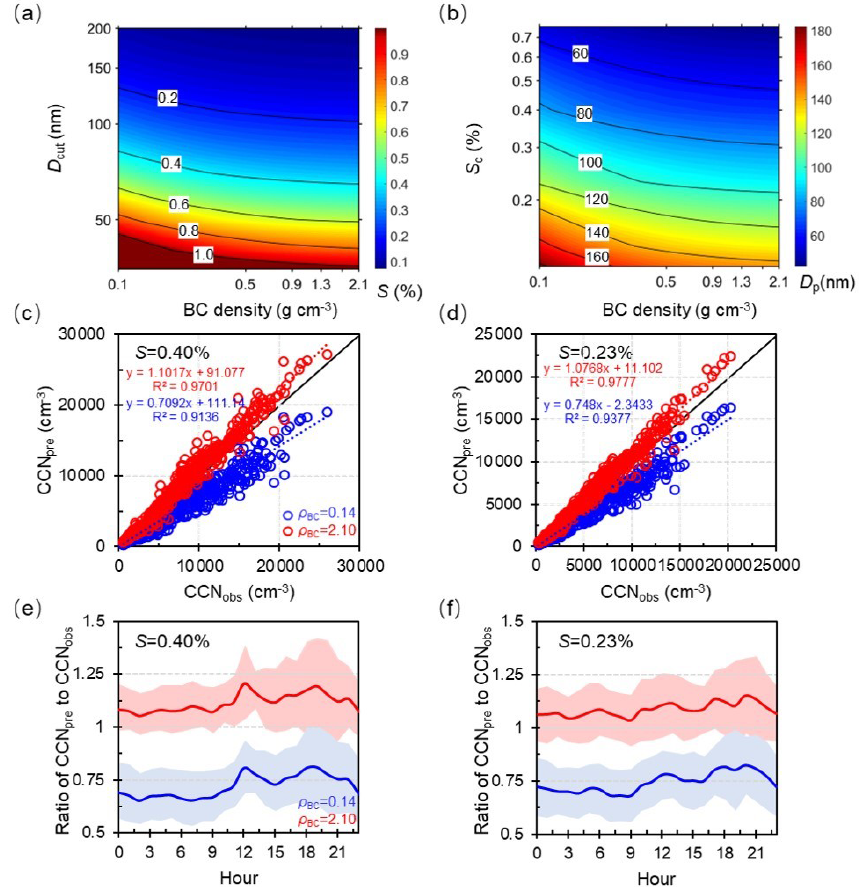
Figure 6. Sensitivity of critical supersaturation ( S c ) (a) and diameter ( D cut ) (b) to the variations in BC density. Predicted N CCN as a function of measured N CCN by varying the density from 0.14 to 2.1gcm − 3 at S = 0 . 40% (c) and S = 0 . 23% (d) . The solid black line is the 1 : 1 line. Diurnal variations in the ratio of the predicted-to-measured N CCN at S = 0 . 40% (e) and S = 0 . 23% (f) are shown.